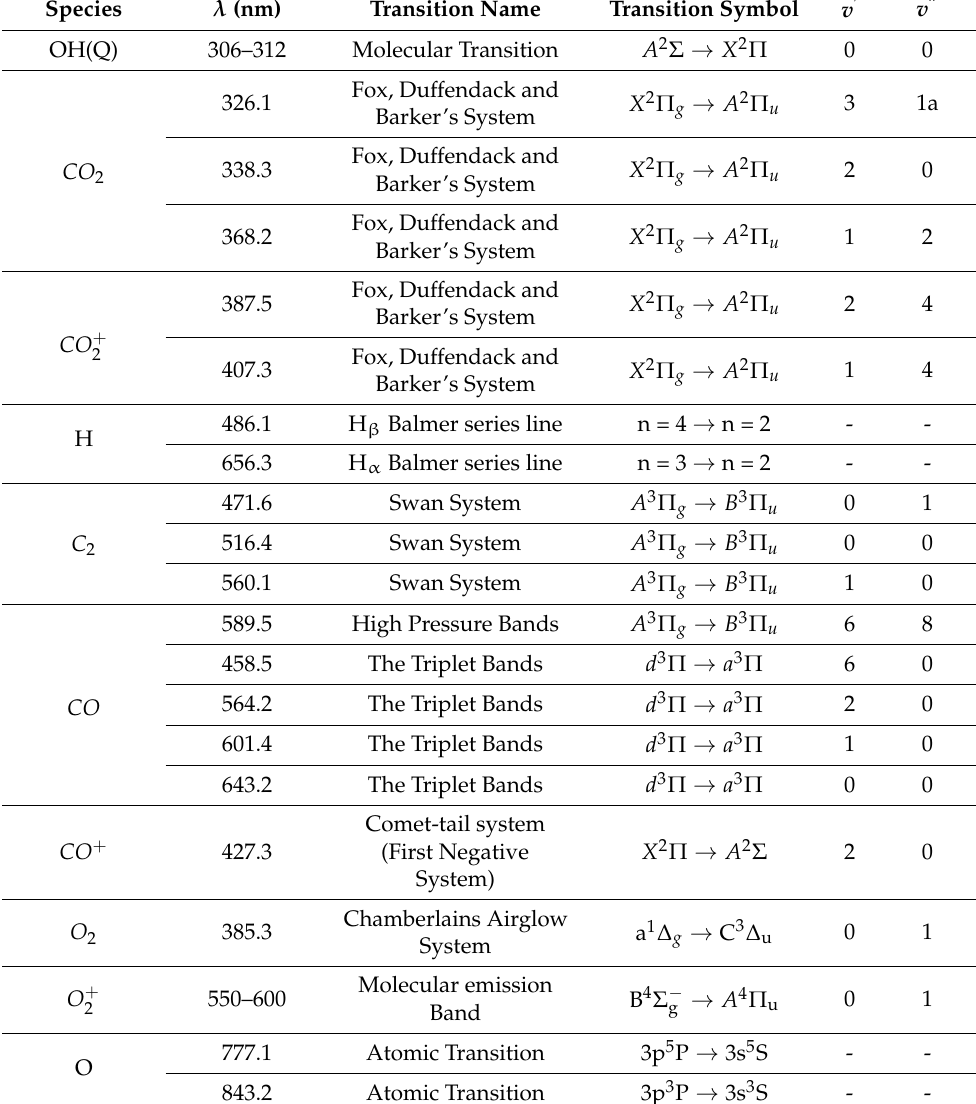
Table 5. Detected peaks for the AC-PPP reactor with CO 2